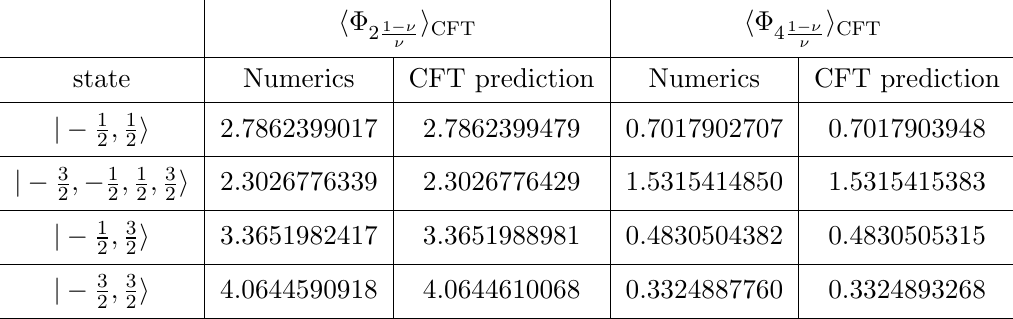
Table 1 . Numerical data for the expectation values of primaries (cid:8) (cid:0) (cid:1) the (cid:23) = 4 ; ‘ = 10 (cid:0) 2 point of the parameter 7